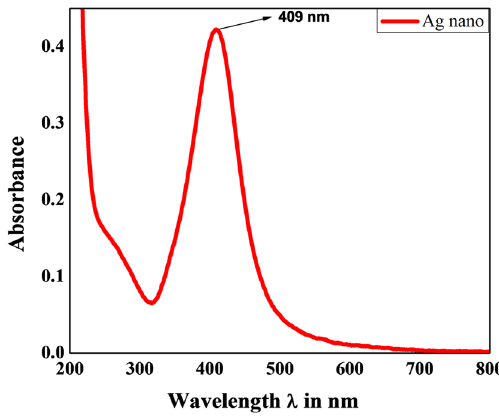
Fig. 1 UV spectra of Ag nanoparticle